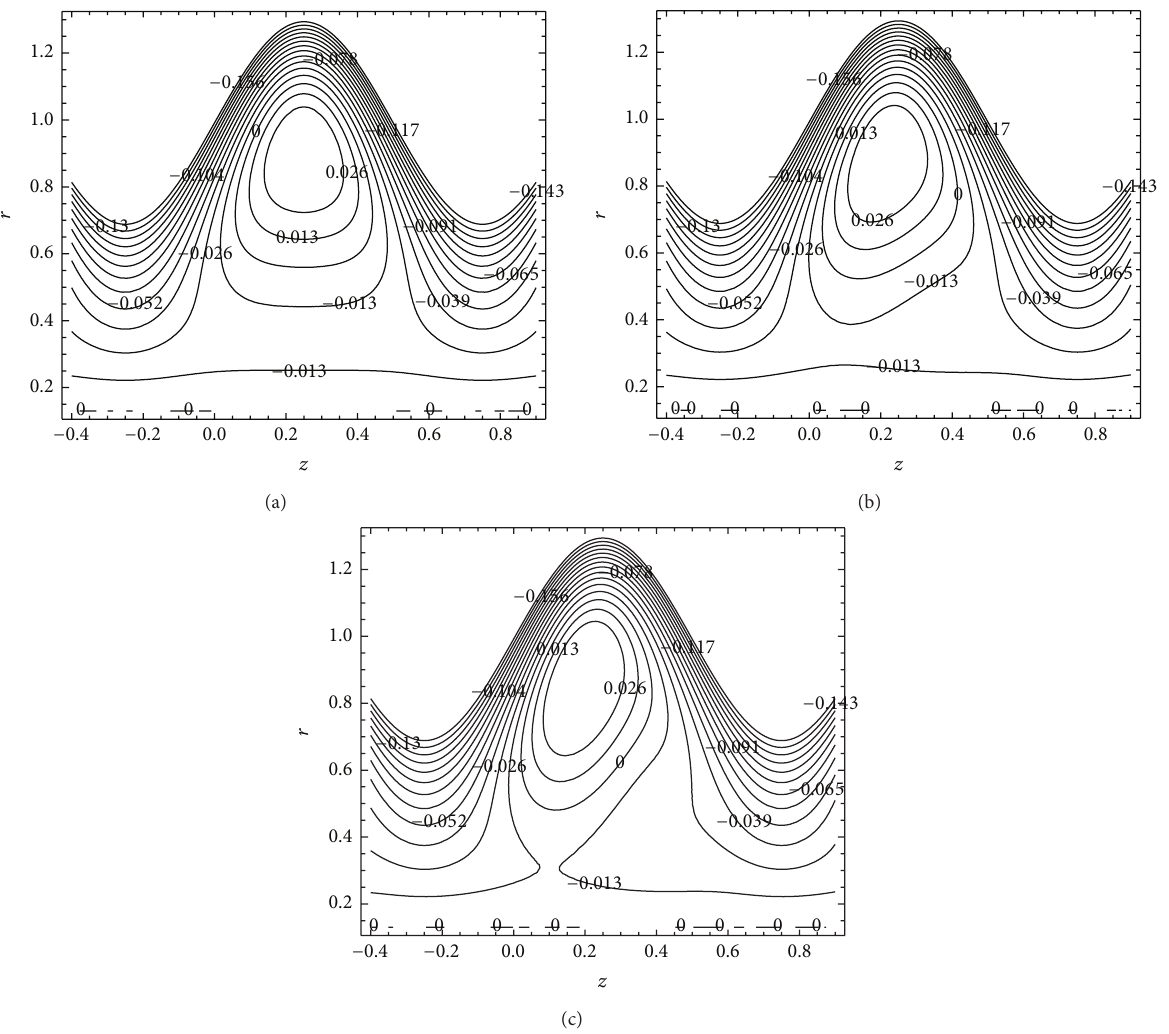
Figure 19: Graph of streamlines for different three values of 𝛿 : (a) 𝛿 = 0 , (b) 𝛿 = 0.08 , (c) 𝛿 = 0.156 at 𝜖 = 0.13 , 𝑄 = 0.7 , Wi = 0.05 , Re = 10 , and 𝜙 = 0.3 , 𝑟 ∈ [𝜖,𝑟 2 ]